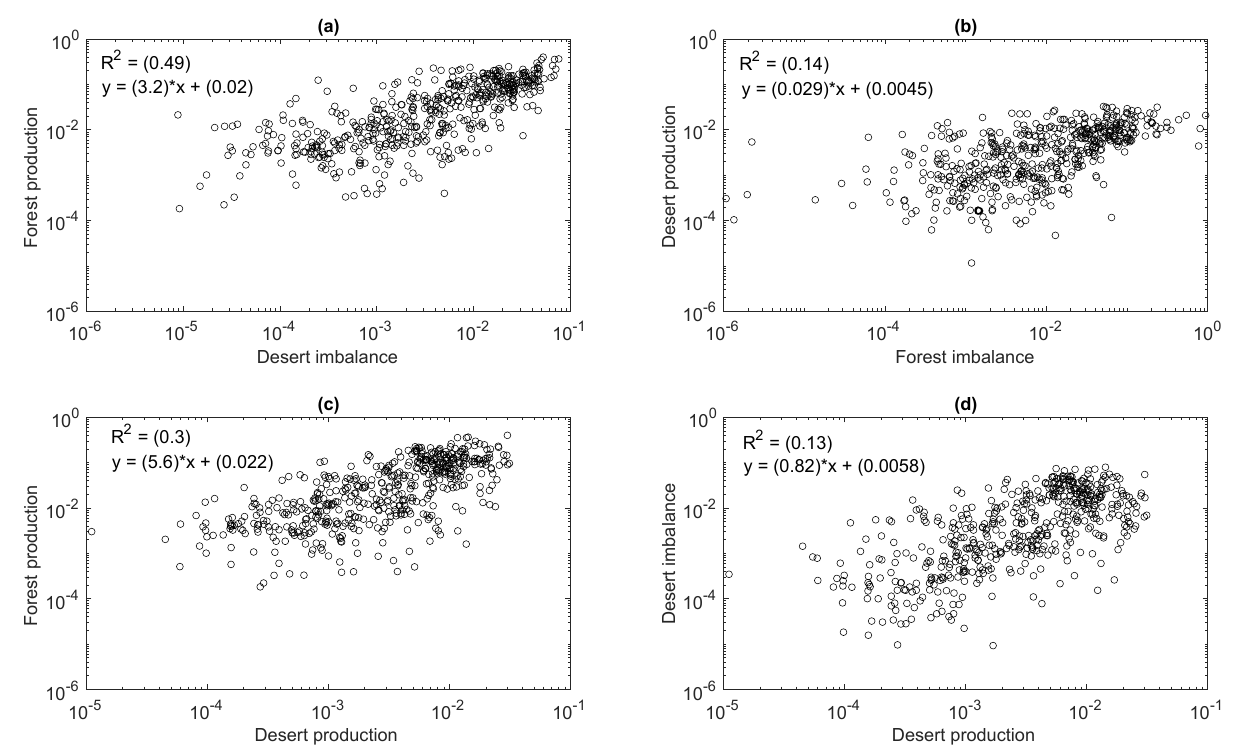
Figure 5. (a) TKE imbalance for the desert vs. TKE production for the forest. (b) TKE imbalance for the forest vs. TKE production for the desert. (c) TKE production for the desert vs. TKE production for the forest. (d) TKE production for the desert vs. TKE imbalance for the desert. Significance: 0.05